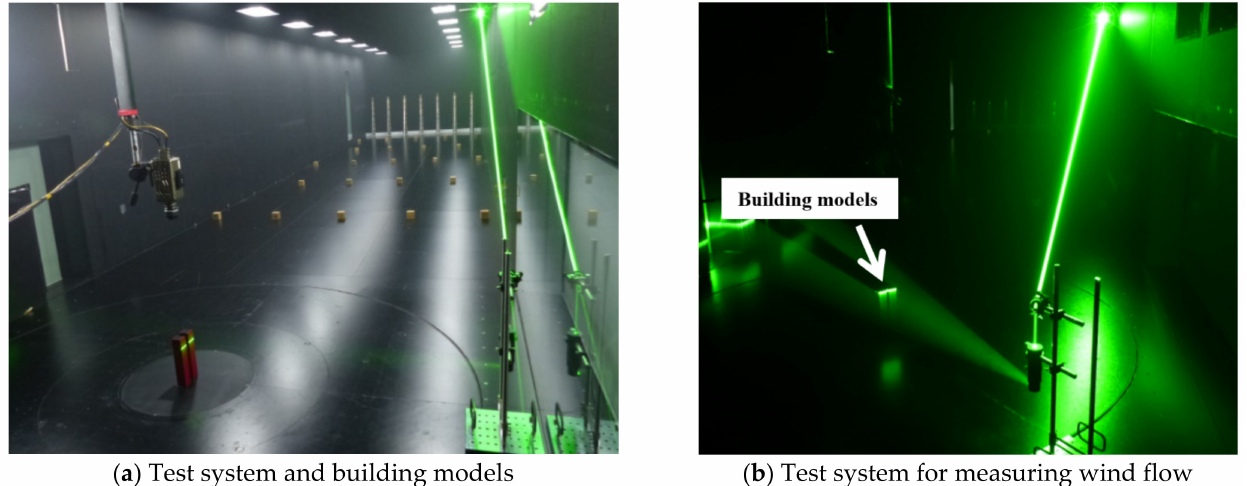
Figure 2. Two building models and equipment for measuring wind flow.